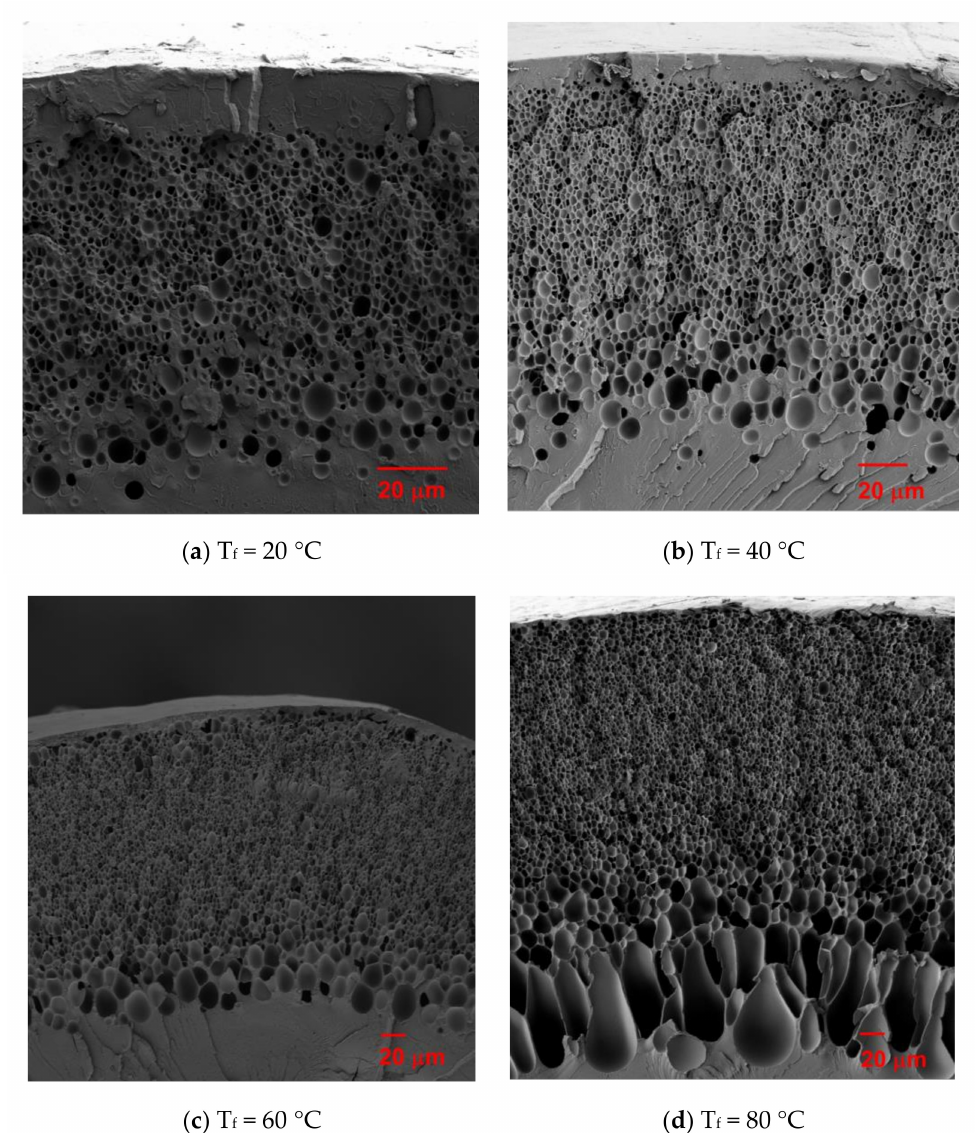
Figure 1. SEM micrographs of the foamed polyethylene terephthalate–polyethylene naphthalate (PET–PEN) copolymer when T f is equal to ( a ) 20 ◦ C; ( b )40 ◦ C; ( c ) 60 ◦ C; ( d ) 80 ◦